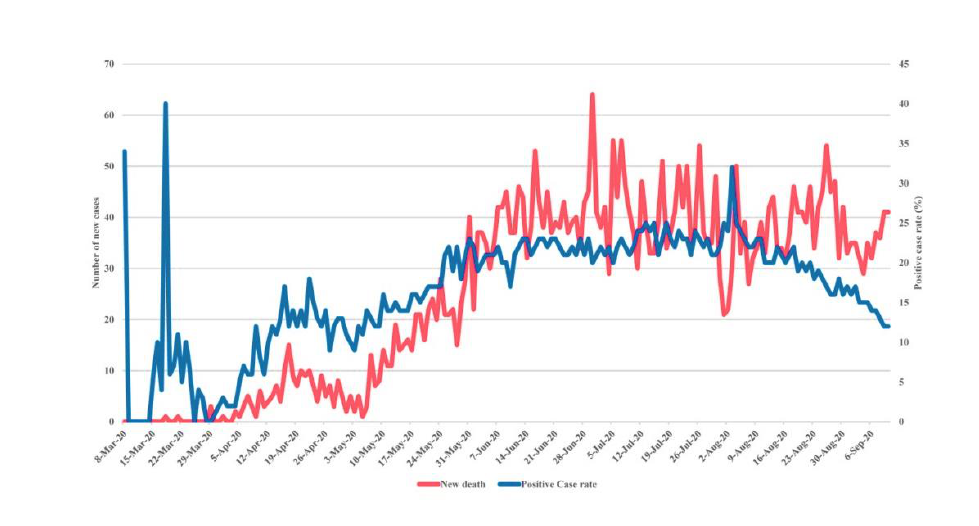
Fig. 2. Trends of the number of daily new deaths and the percentage (%) of test positive rate